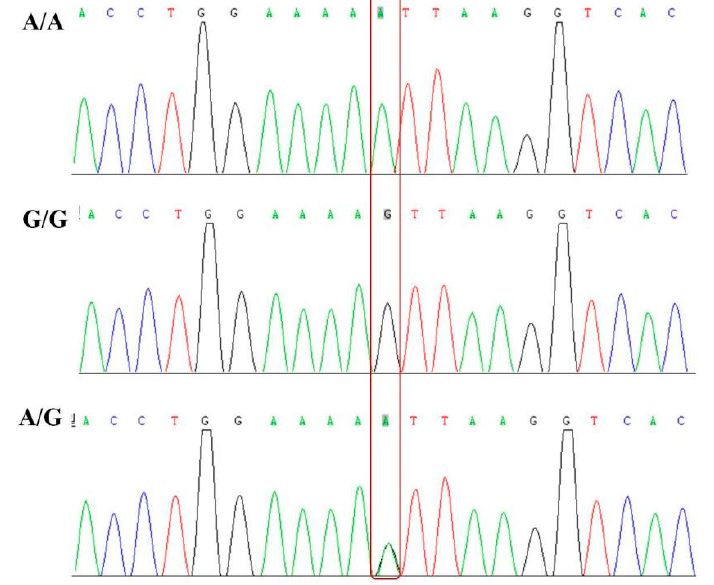
Figure 3. Sanger sequencing revealed the genotype of the Sme2.5_01158.1_g00001.1 mutation site.